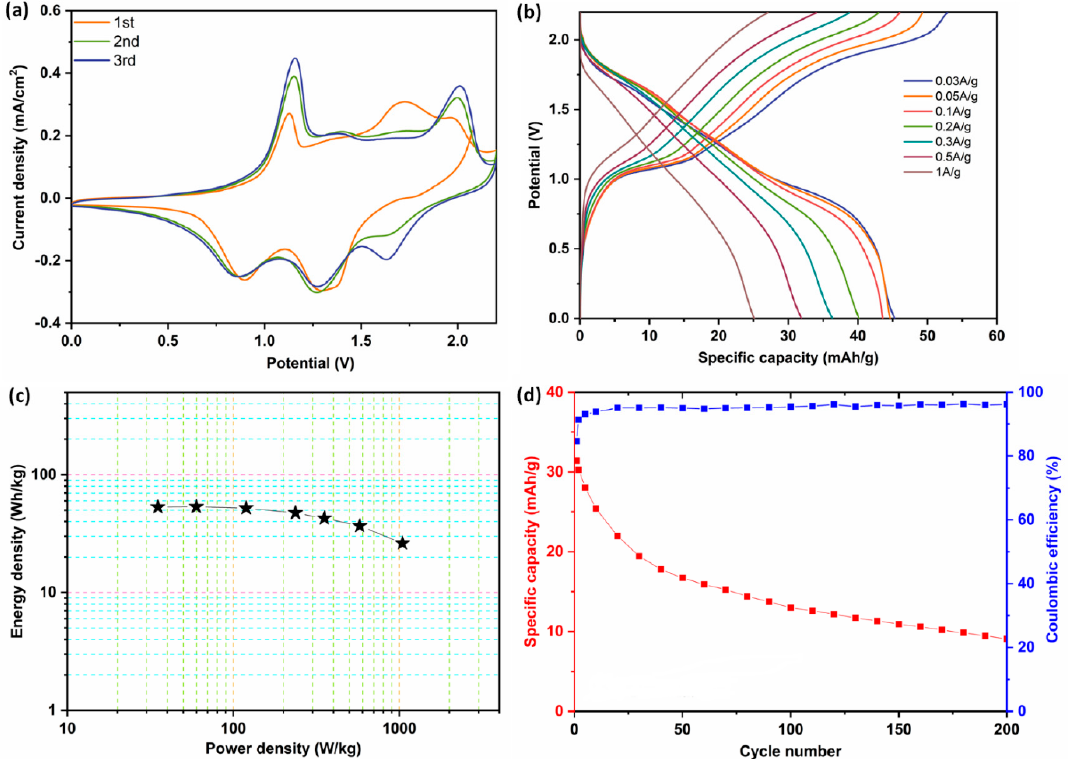
Figure 6. ( a ) CV analysis, ( b ) GCD curves, ( c ) energy density vs. power density plot, and ( d ) cyclic stability of two-electrode systems using PTCDI/rGO (anode), LMO (cathode), and the hybrid Li/Mg electrolyte. Reprinted with the permission of [107].